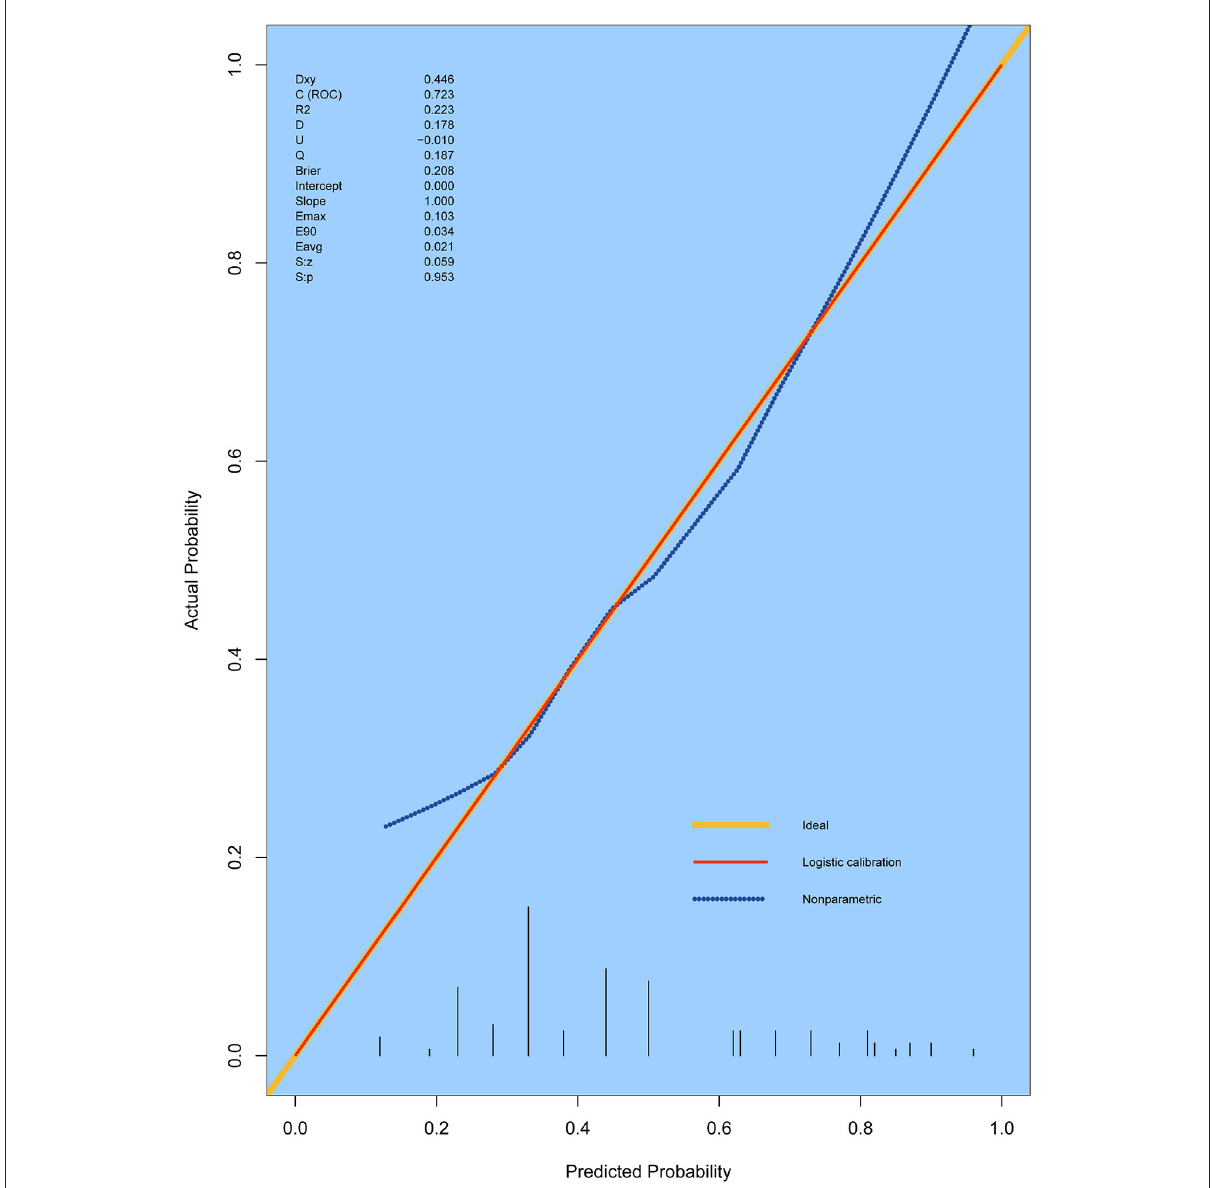
FIGURE5 Calibration curves for the prediction model. The curves describe the calibration of the nomogram in terms of the agreement between predicted risks (X-axes) and actual outcomes (Y-axis). The diagonal line indicates a perfect prediction by an ideal model. E max, maximum error; E aver, average